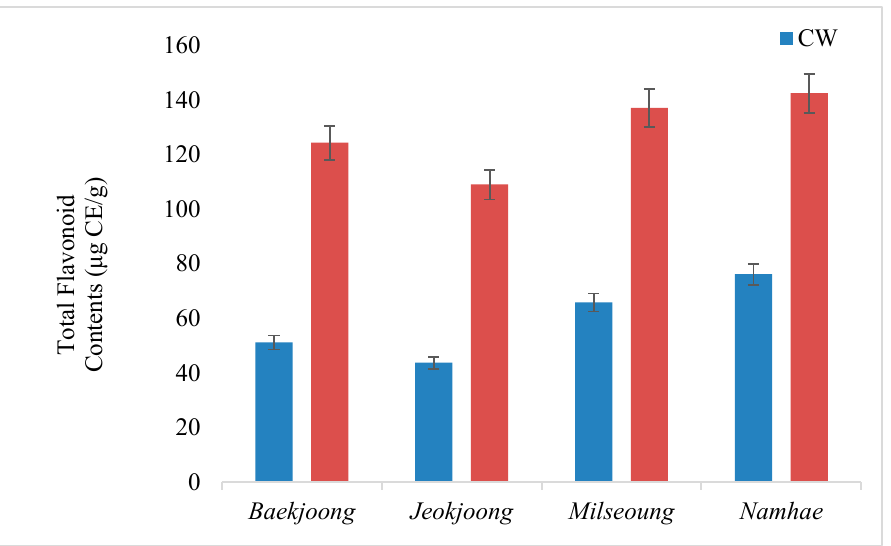
Figure 3. Total flavonoid contents of cooked wheat and fermented wheat. Error bars (mean ± SD) represent significant differences among the treatments. The data were analyzed with a one-way ANOVA followed by Duncan multiple range tests ( p < 0.05). CW: cooked wheat, FW: fermented wheat.